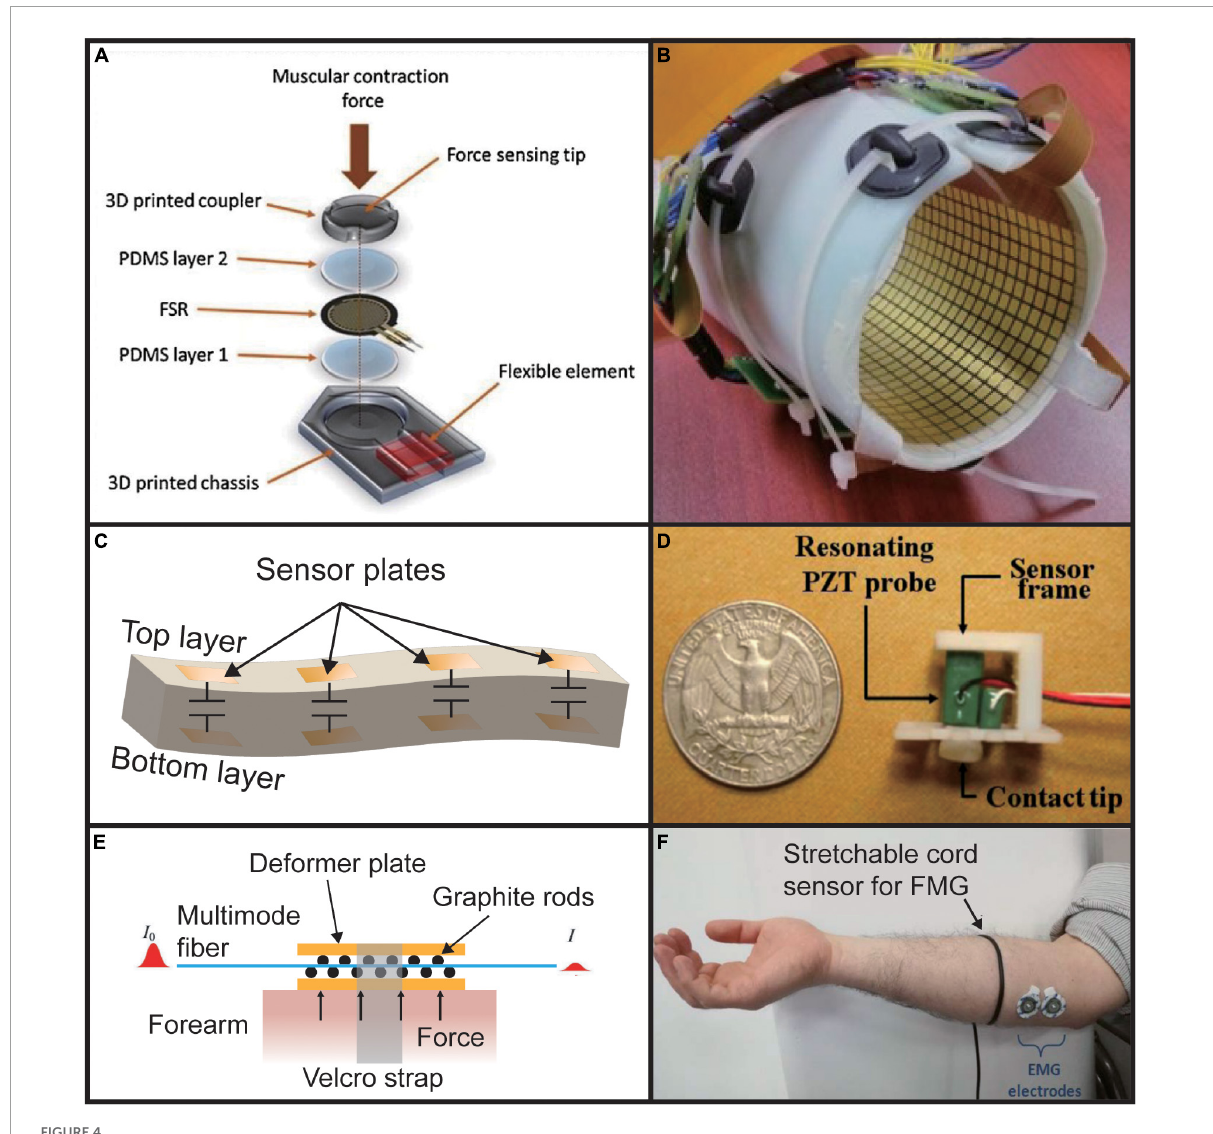
FIGURE4 Different types of FMG sensors. (A) RPTF-based sensor. Reproduced with permission (Prakash et al., 2021). Copyright 2020, Elsevier; (B) high density piezo-resistance sensor array. Reproduced with permission (Radmand et al., 2016). (C) Capacitance-based sensor (Truong et al., 2018). (D) Piezoelectric-based sensor. Reproduced with permission (Han and Kim, 2013). Copyright 2013, Elsevier. (E) Optical fiber-based sensor (Fujiwara et al., 2018). (F) Wide range stretch sensor. Adapted from Bifulco et al. (2017). Copyright 2017,